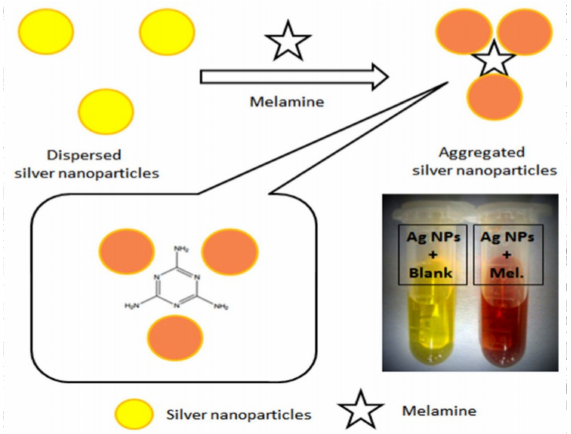
Figure 19. Schematic illustration of melamine detection and visual color change of Ag NPs after addition of melamine. The insert is a photograph of visual color change of Ag NPs upon addition of 1 mg/L of melamine (reproduced with permission from Reference